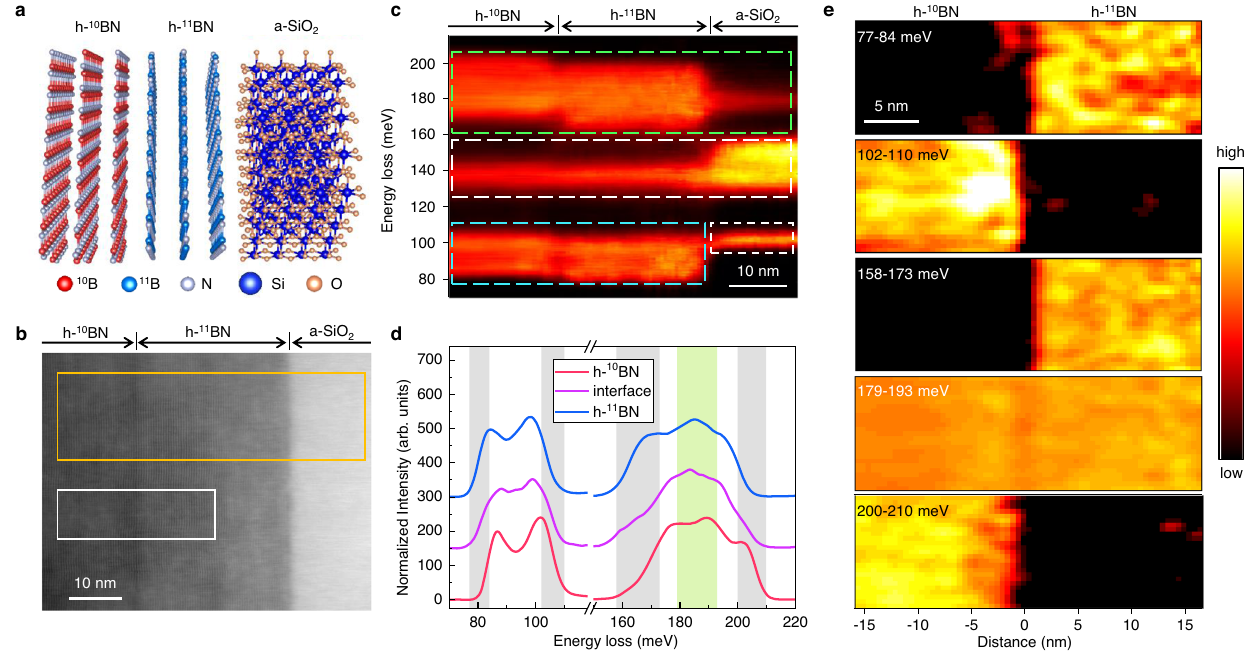
Fig. 1 | Isotope identi fi cation of h − 10 BN/h − 11 BN interface. a Schematic of the assembled stack of h- 10 BN, h- 11 BN, and Si substrate with amorphous SiO 2 (a-SiO 2 ) layeronsurface. b HAADFimageofthe h- 10 BN/h- 11 BN/a-SiO 2 cross-section. c STEM- EELSvibrationalspectrawereacquiredattheregionoftheorangerectanglelabeled in b . The vibrational signals from the h-BN in-plane direction, a-SiO 2 and h-BN out- of-plane direction are labeled by green, white and blue dashed rectangles,